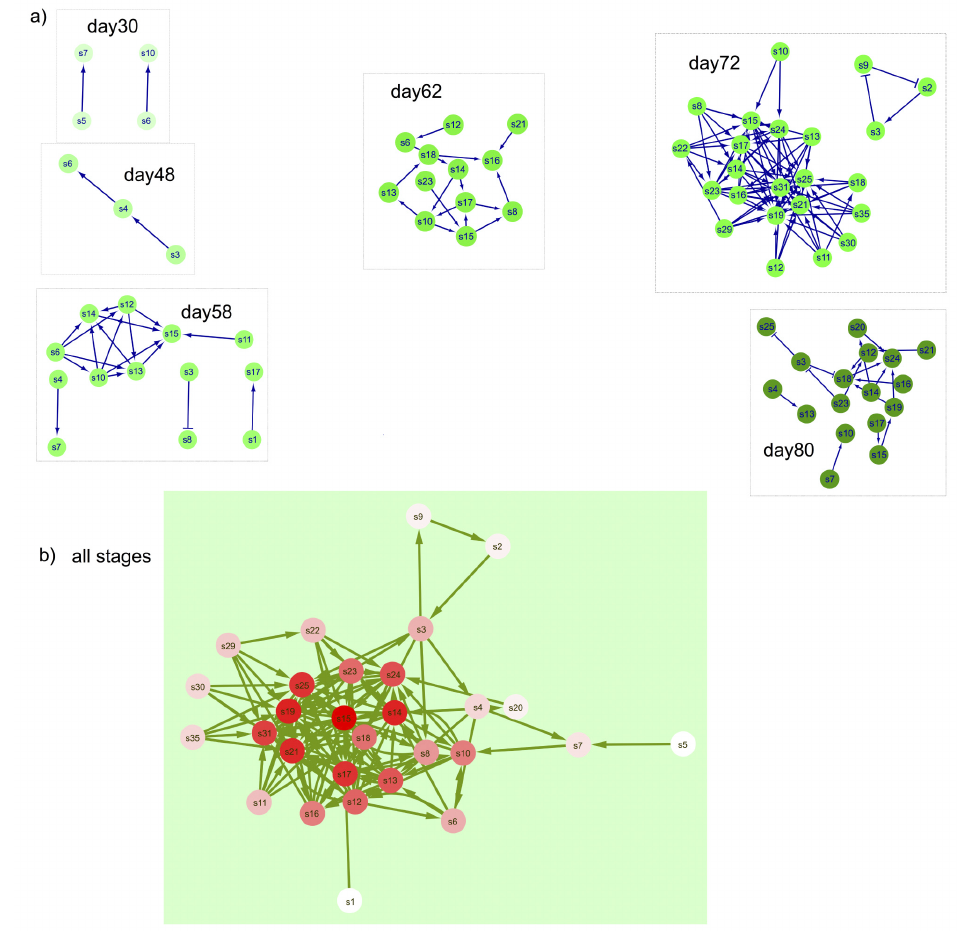
Figure 5. Network visualization of significantly co-occurring SCU pairs at each plant stage, with the identifier number for each SCU shown with the node label “s” plus the number. If there were no significant co-occurring SCU, then that day was not shown. Negative interactions between SCU nodes are shown as edges with a barred arrow tip and positive correlations between SCU are indicated with pointed arrows. a ) Significant co-occurring SCU from each sampled stage. b ) Results of DyNet analysis of co-occurring SCU most changed across stages. Only significant co-occurring SCU (as shown in part a ) were analyzed using DyNet. Intensity of the red color of nodes indicates amount of change across stages, with darker color indicating the most ‘rewiring’.